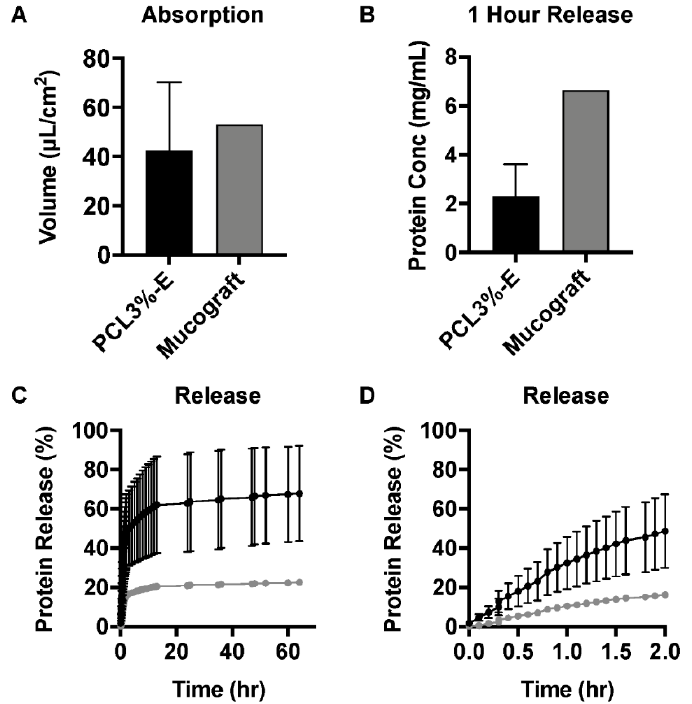
Figure 3. Protein absorption and release profiles from PCL3%-E in comparison to Mucograft ® . ( A ) Absorption capacity and ( B ) protein release in the first hour. ( C ) The cumulative protein released as a percentage of the initial absorbed volume shown over 60 h and ( D ) the first 2 h. Black—PCL3%-E ( n = 2), grey—Mucograft ® ( n = 1).